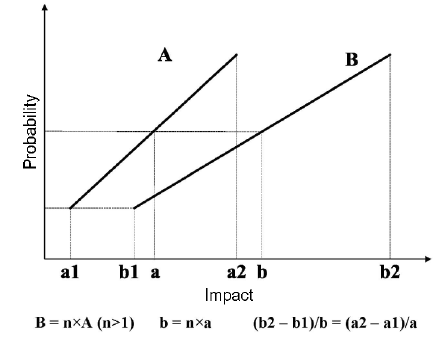
Fig. 6 . Multiplication of cumulative curve by coefficient